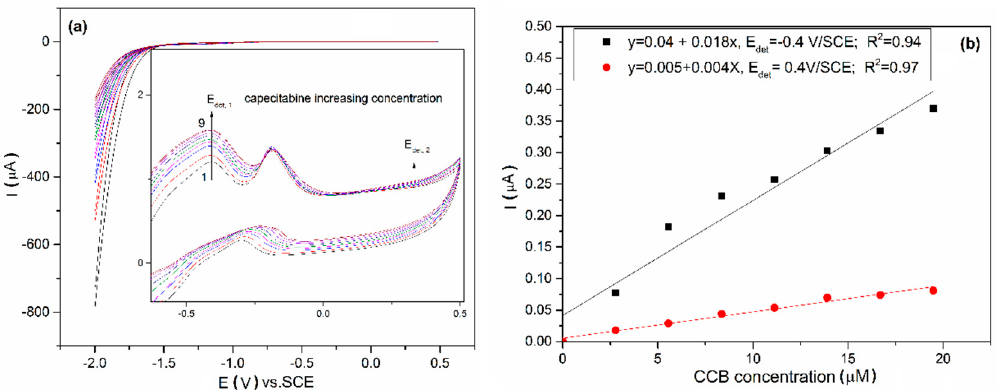
Figure 9. ( a ) Cyclic voltammetry recorded at LaFeO 3 / BDD electrode in 0.1 M NaOH (curve 1) and in the various CCB concentrations ranged from 2.5 µ M to 22.5 µ M (curves 2–9), scan rate of 0.05 Vs − 1 . ( b ) Calibration plots of anodic peak with various CCB concentrations ranged from 2.5 µ M to 22.5 µ M (curves 2-9).